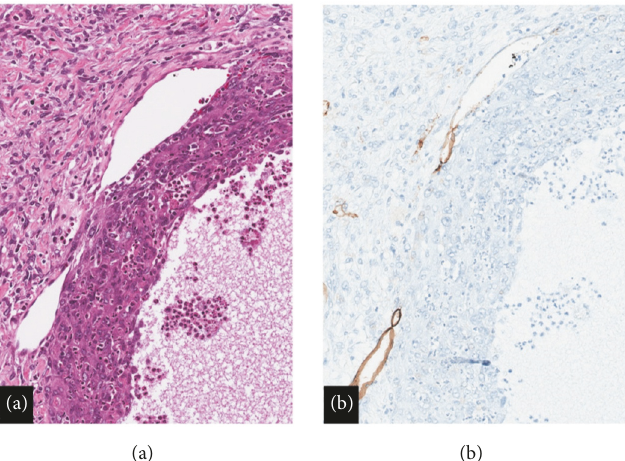
Figure 6: (a) Histology: central cystic pseudoangiomatous space with acuteinflammation and adjacent compressed small thin-walled vessels (Hematoxylin & eosin, 20X). (b) Immunohistochemistry: CD34, immunoreactivity present in thin-walled vascular spaces with absence of endothelial marking in larger pseudoangiomatous cystic cavity